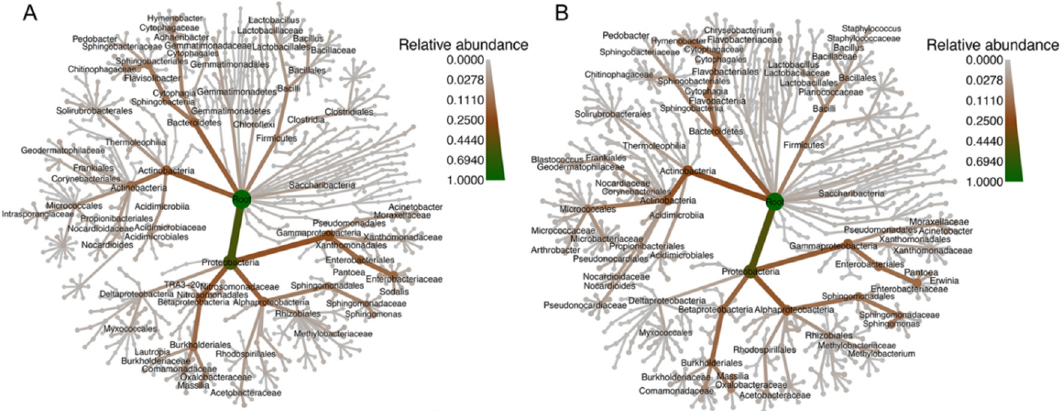
Figure 3. “Heat trees” indicating the hierarchical phylogenetic relationships and relative abundances of taxa within ( A ) O. lignaria and ( B ) O. ribifloris . Branch color denotes relative abundance of the taxonomic rank within all samples from within each species, and taxon labels represent the 75 most proportionally abundant taxa.